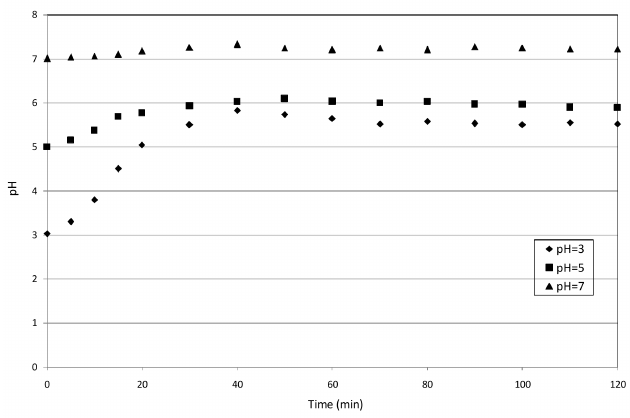
Figure 11. pH trends during the tests conducted with mZVI and initial Pb 2+ concentration of 30 mg/L.